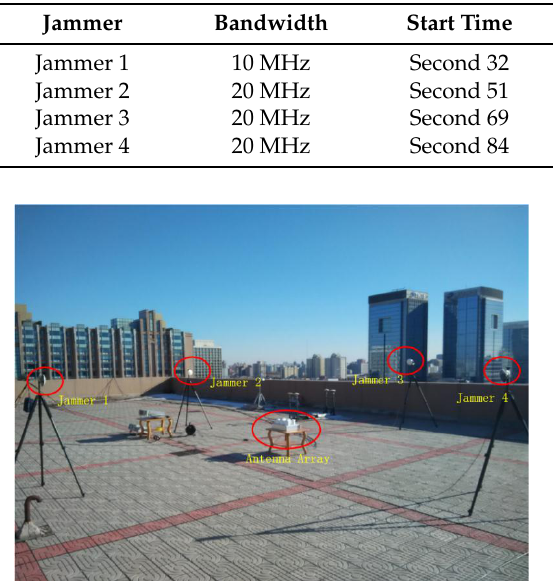
Figure 18. A photo of the experiment setup.